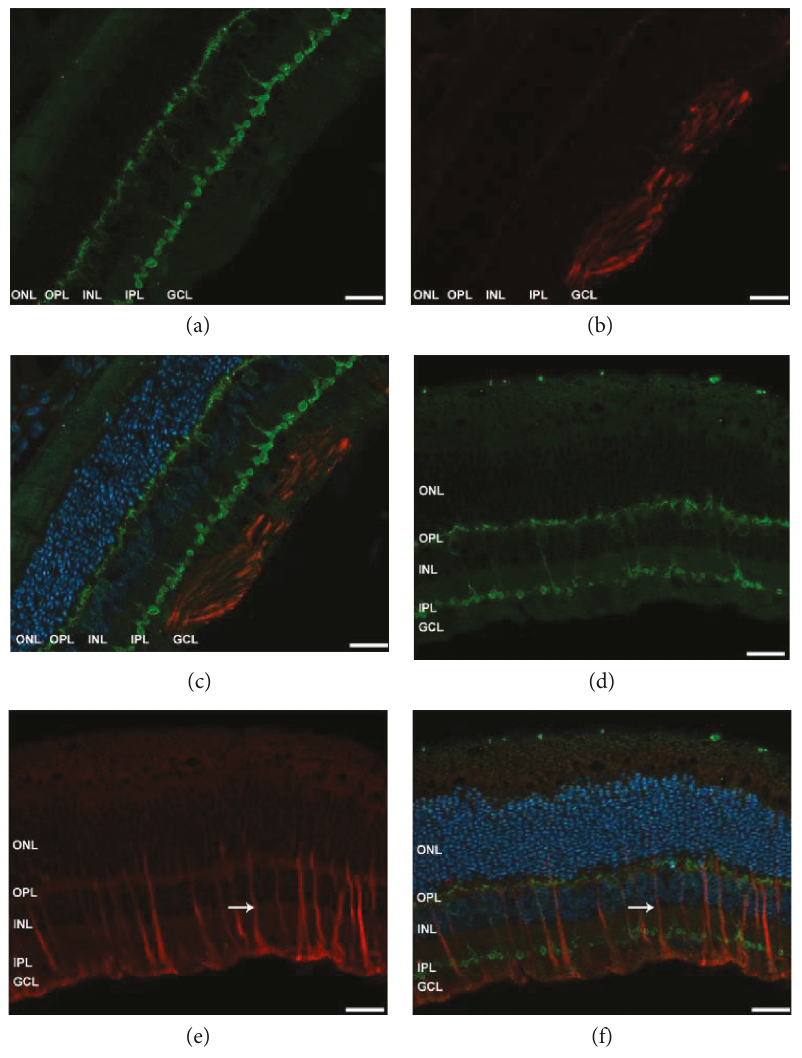
Figure 11: Expression pattern of GFAP in the control and experimental retinas. Representative images of the control retinal sections ((a), (b), and (c)) and detached retinas ((d), (e), and (f)) labelled for PKC α (green), GFAP (red) counter stained with DAPI (blue). IS =inner segment, OS=outer segment, ONL =outer nuclear layer, INL =inner nuclear layer, OPL=outer plexiform layer, INL =inner nuclear layer, IPL=inner plexiform layer, and GCL=ganglion cell layer. Original magni fi cation ×